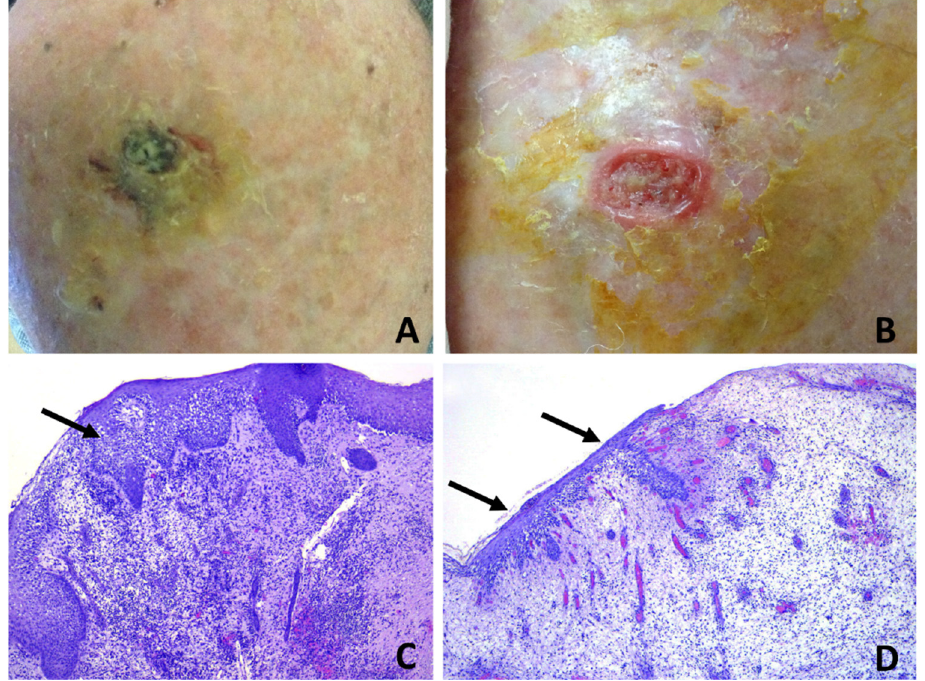
Figure 8. Erosive pustular dermatosis of the scalp; ( A ) black-greenish crusted plaque on the vertex; ( B ) removal of the crust evidences a reddish, raised, undermined border with a purulent granulation base, resembling pyoderma gangrenosum. The lesion was completely excised ( C ) specimen from the margin shows intrafollicular spongiform pustules (arrow); ( D ) specimen from the center evidences erosion with granulation tissue and neutrophilic micro-abscesses within the epithelium of regenerating hair follicles (arrows). The continuing activity of the disease may be inferred by the spongiform pustulation observed in the newly forming hair follicles at the top of the early granulation tissue.